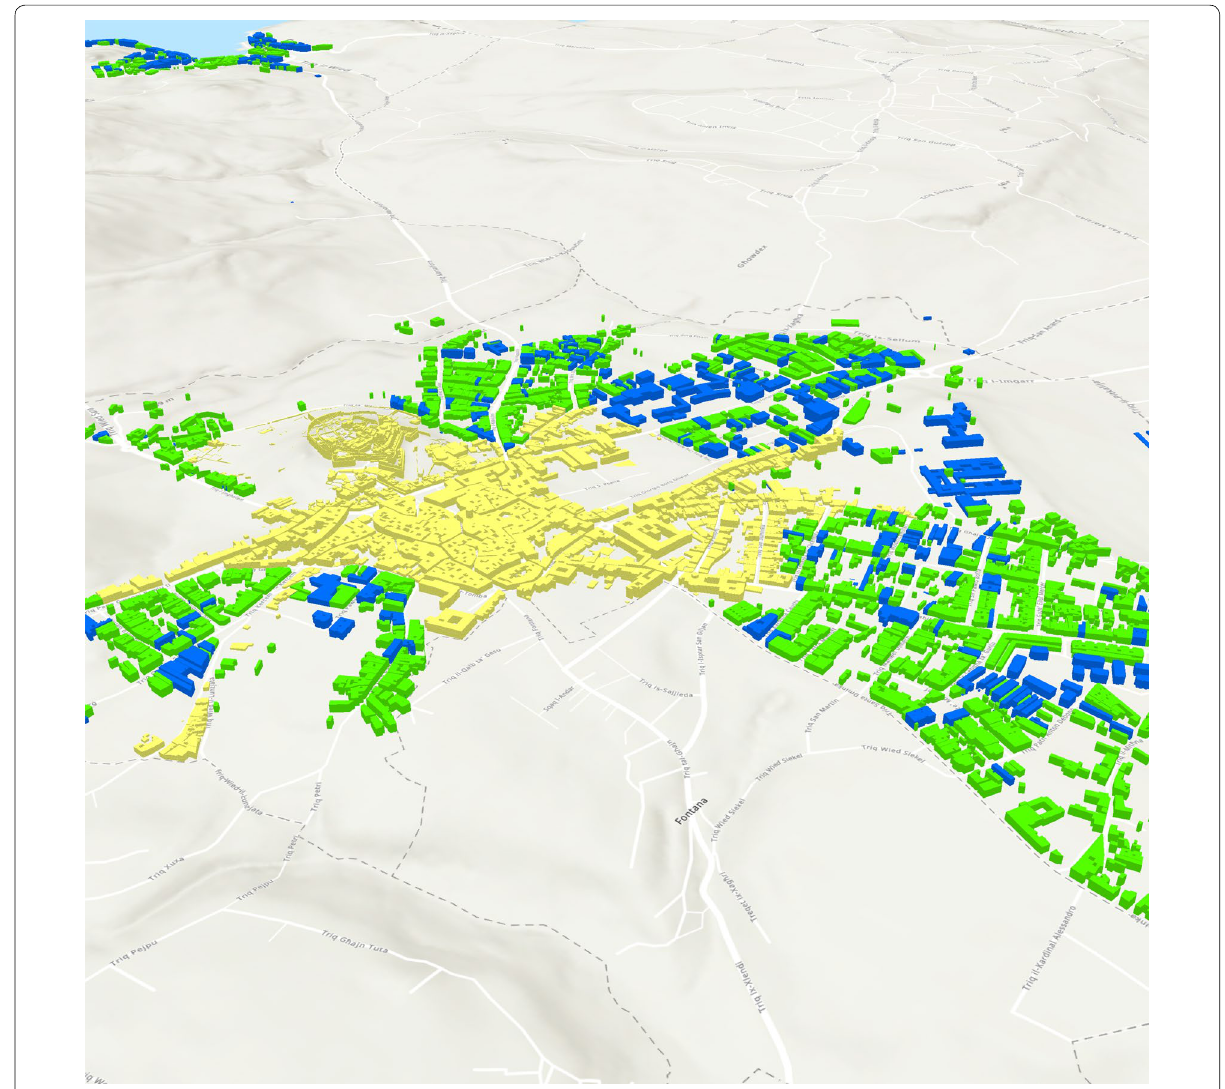
Fig. 3 Victoria: UCAs (yellow); area inside buffer of 250 m—no infill (blue); area inside buffer of 250 m—infill